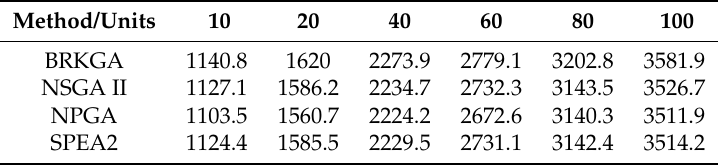
Table 10. Extent average measures over 10 optimization